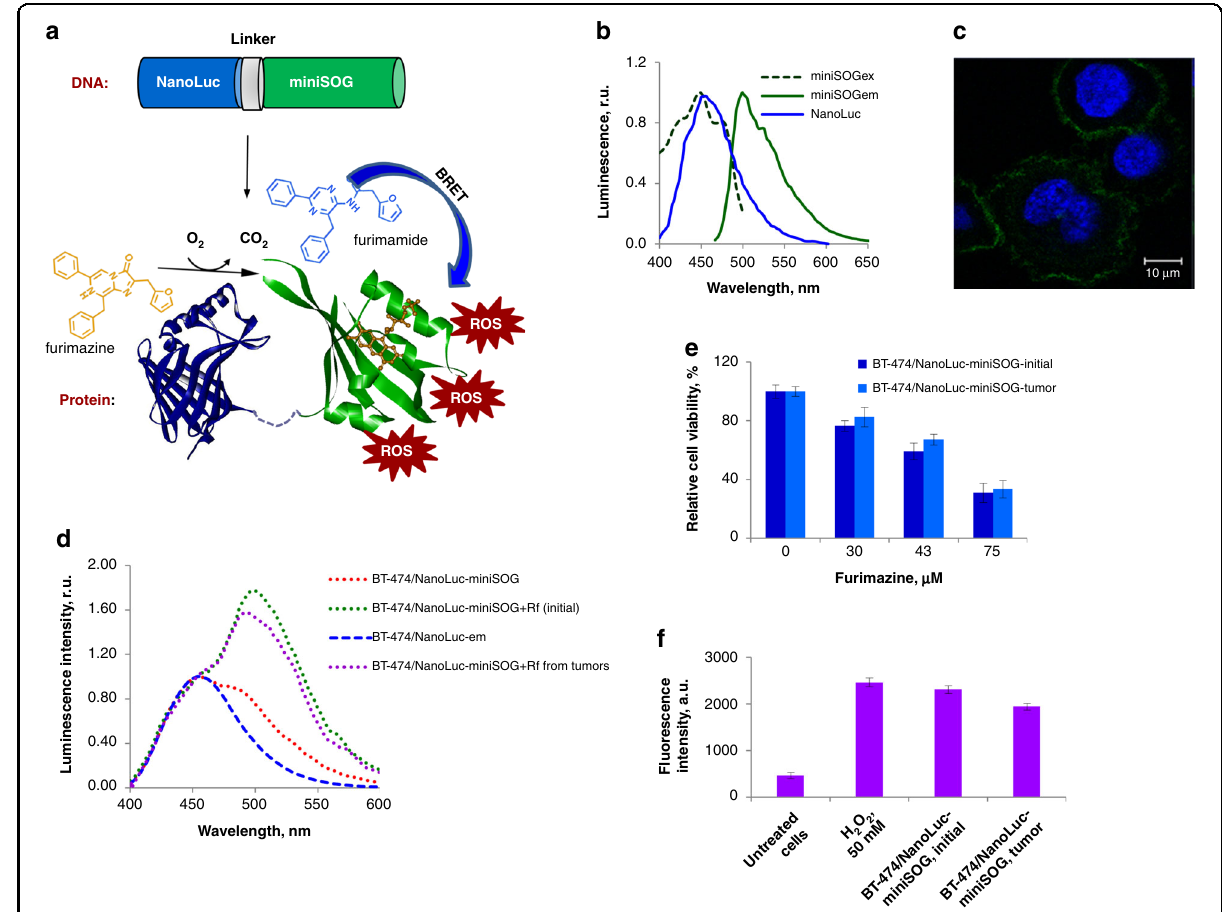
Fig. 1 NanoLuc-miniSOG platform for genetically encoded BRET-activated PDT. a Schematic presentation of the concept. NanoLuc luciferase is fused to miniSOG phototoxic protein at genetic level. The energy generated by luciferase-substrate furimazine upon its oxidation by NanoLuc is nonradiatively transferred to miniSOG resulting in its excitation and generation of ROS, which in turn kill cancer cells. b Normalized emission spectrum of oxidized NanoLuc substrate (NanoLuc, blue line), normalized excitation (mSOG ex , green dotted line) and emission (mSOG em , green line) spectra of miniSOG. c Confocal microphotograph of BT-474-based stable cell line with NanoLuc-miniSOG located in the plasma membrane. Fluorescence signals in green (miniSOG) and blue (Hoechst 33342) channels are presented. d Normalized emission spectra of BT-474/NanoLuc-mem (blue dotted line) and BT-474/NanoLuc-miniSOG-mem initial cell lines (green dotted line) and BT-474/NanoLuc-miniSOG isolated from the tumor (magenta dotted line) in the presence of 75 μ M furimazine and ribo fl avine and BT-474/NanoLuc-miniSOG in the absence of ribo fl avin (red dotted line). e In vitro cytotoxicity studies of NanoLuc-miniSOG activated by BRET. The data of MTT assay are presented for BT-474/NanoLuc-miniSOG initial cell line and BT-474/NanoLuc-miniSOG from the tumor in the presence of different furimazine concentration. The data are shown as the mean ± SD ( n = 3). f ROS production in NanoLuc-miniSOG BRET-activated system. Fluorescence intensity of DCF, an indicator of ROS, in BT-474/NanoLuc- miniSOG initial cell line and BT-474/NanoLuc-miniSOG from the tumor in the presence of 75 μ M furimazine are presented. The measurement performed at 529 nm. The data are shown as ±SD ( n =